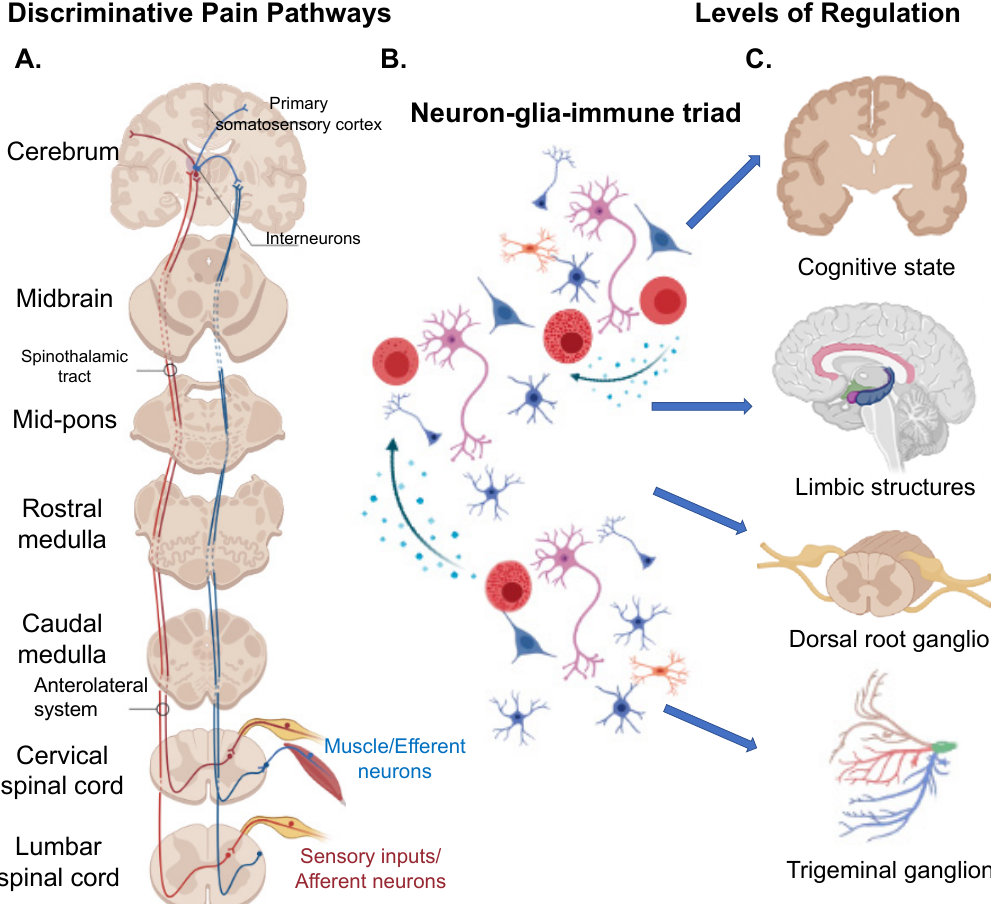
Figure 1. Pain pathways and levels of regulation. ( A ) The pain signal cascades through the central and peripheral nervous systems. Noxious sensory inputs from the lower and upper parts of the body are sensed by the afferent neurons that feed to the lumbar and the cervical spinal cord divisions, respectively. The information is relayed to the primary somatosensory cortex of the cerebrum; interneurons in the CNS transmit information to the efferent neurons that relay signals from the CNS to the effector organs, such as the muscles and glands. ( B ) The neurons in the CNS or the PNS are surrounded by glial cells. Resident or infiltrated immune cells release mediators that in turn modulate glial and neurons activity function at various levels. ( C ) Pain signal is regulated at several levels; an individual’s cognitive state regulates pain perception. The limbic system is key for integrating pain perception. Immune and glial cells respond to injury or noxious stimuli and modulate function of dorsal root ganglia, trigeminal ganglion, and limbic structures to alter pain perception. All these inputs are integrated and together constitute one’s cognitive state, which can affect pain perception and experience. Pain can be regulated at each level via the mediators summarized in Table 1. Table 1. Neurotransmitters and neuromodulators of the central, peripheral, and enteric nervous systems.